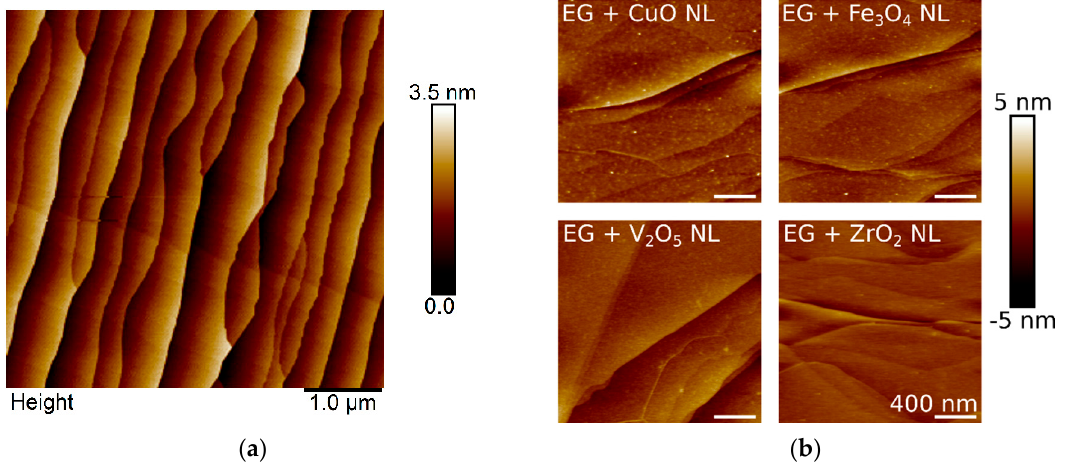
Figure 1. AFM images of pristine epitaxial graphene (PEG) ( a ) before and ( b ) after the decoration with nanolayers (NLs).